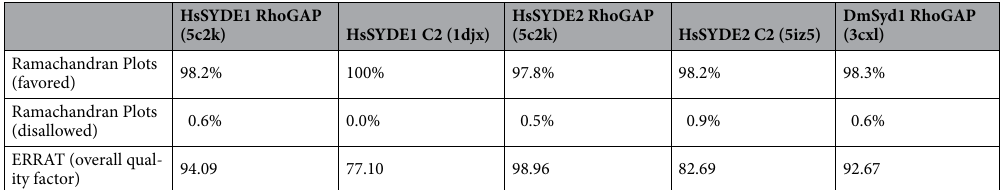
Table 2. Evaluation of predicted structural models. The model based on template-based prediction was calculated. Ramachandran plots showed several disallowed residues in RhoGAP and HsSYDE2 C2 domain except HsSYDE1 C2 domain with completely favored score in all the predicted region. Each predicted model showed high score in overall quality factor for non-bonded atomic interactions by